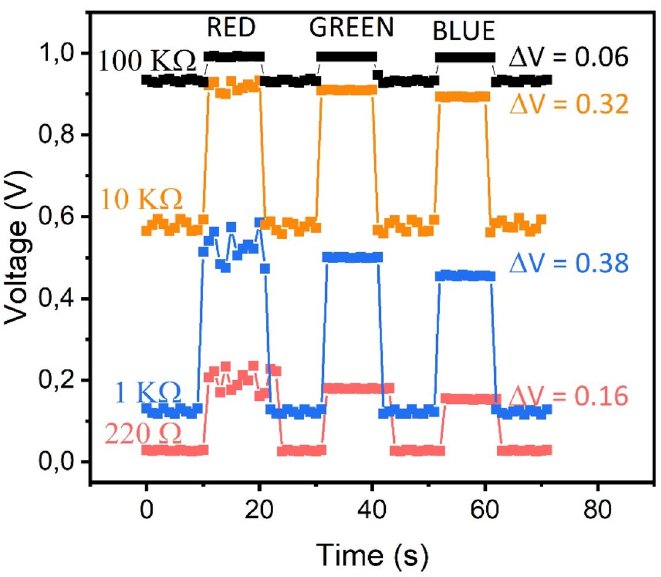
Figure 2. Voltage measured (V) versus time (s) for a set of resistances with four orders of magnitudes of difference (0.22, 1, 10 and 100 kΩ). The highest voltagegradient is displayed for the 1kΩ resistance value.